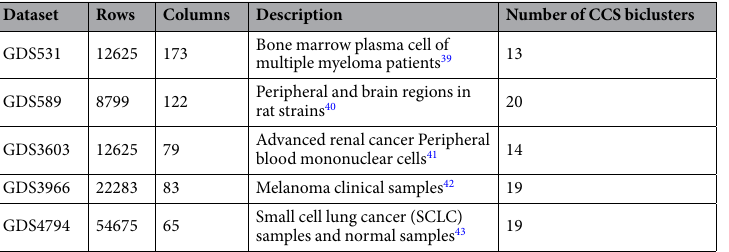
Table 2. Summary of the gene expression datasets and number of CCS biclusters obtained for θ = 0.8.